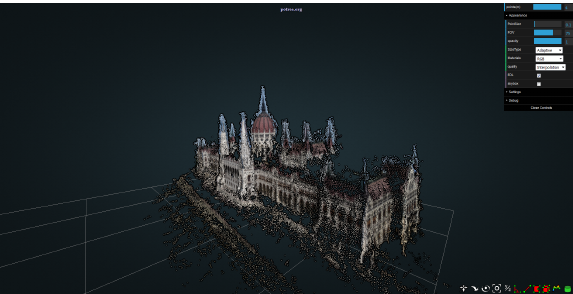
Figure 10. The cleaned error-free Parliament in a web